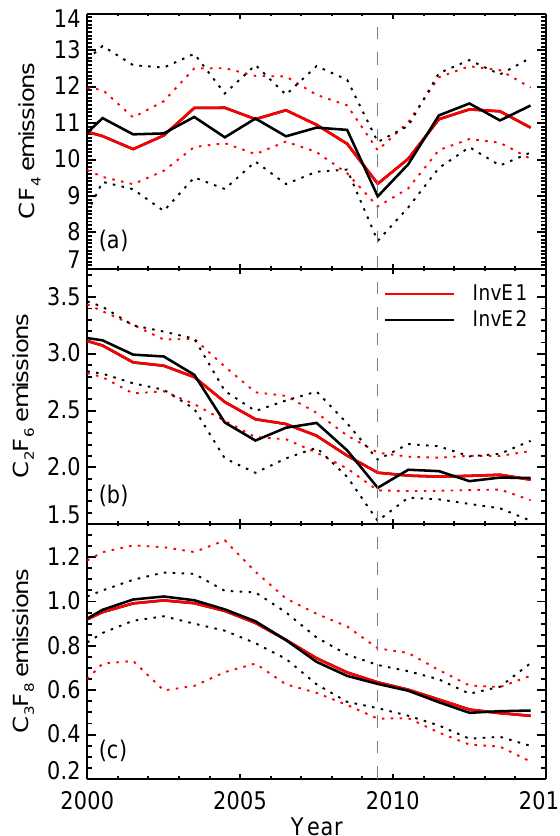
Figure 8. (a) CF 4 , (b) C 2 F 6 and (c) C 3 F 8 emissions (Ggyr − 1 ) from 2000 for the InvE1 inversion in red and the InvE2 inversion in black. Uncertainty ranges shown for both models are 95% confidence in-